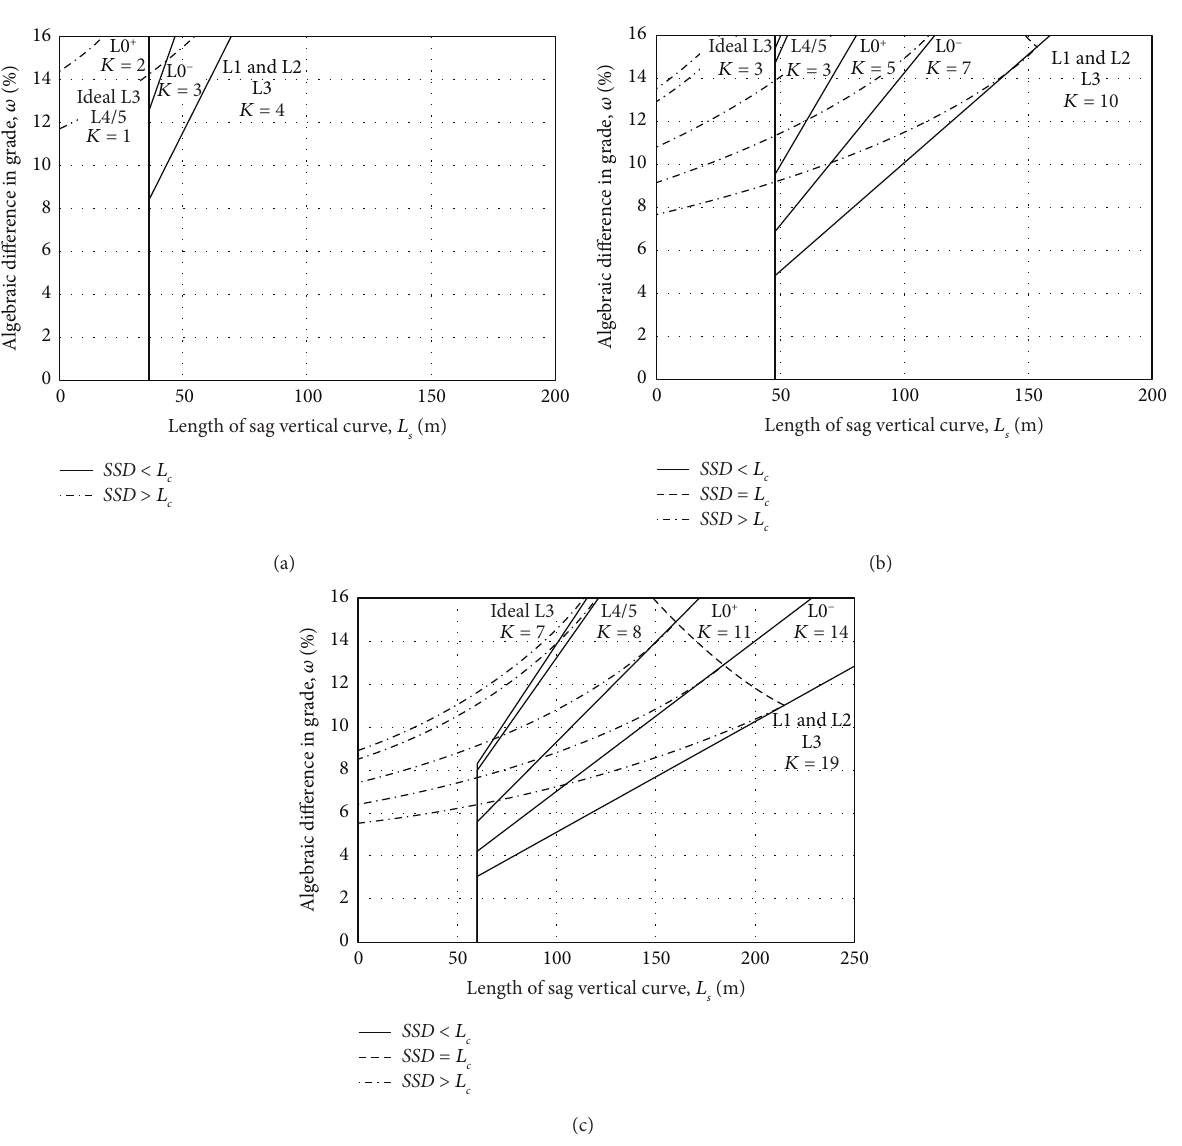
Figure 8: Design controls for sag vertical curves at undercrossings for all scenarios: (a) V � 60km/h; (b) V � 80km/h; (c) V � 100